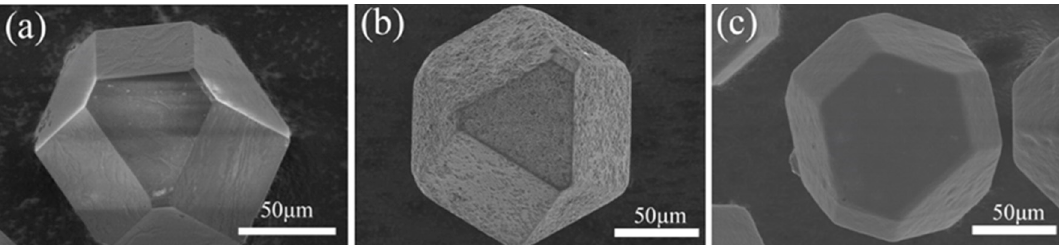
Figure 2. SEM images for ( a ) uncoated diamond, ( b ) B 4 C-coated diamond, ( c ) Cr–B–C-coated diamond.